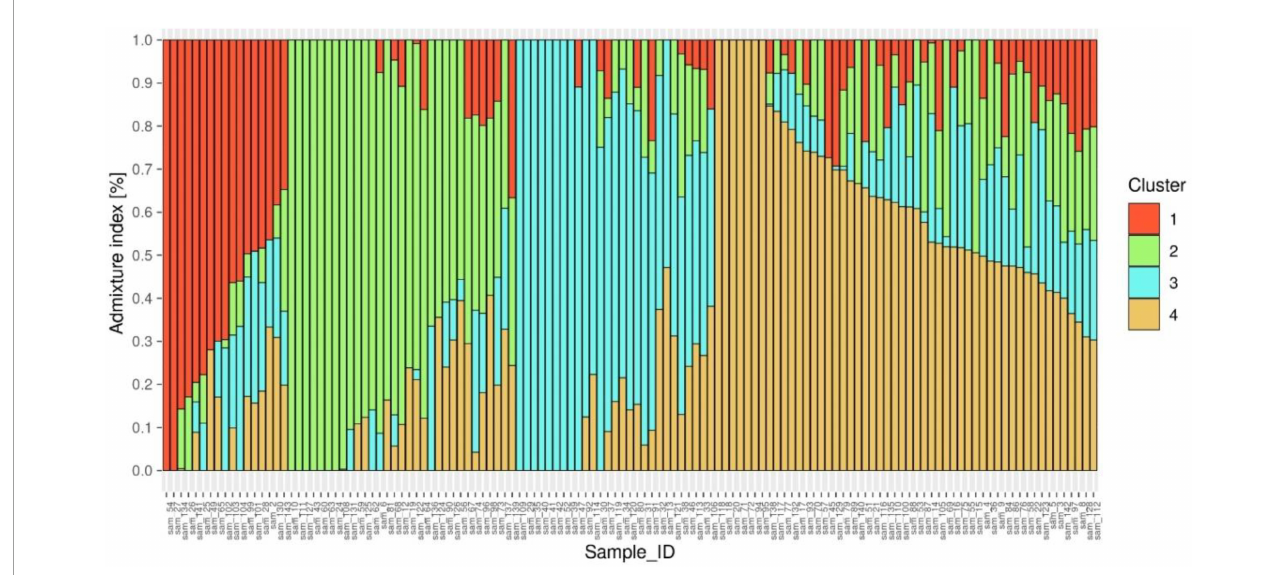
FIGURE4 Population genetic structure plot of 127 diverse mungbean genotypes with optimal population number k = 4 with four different colors.